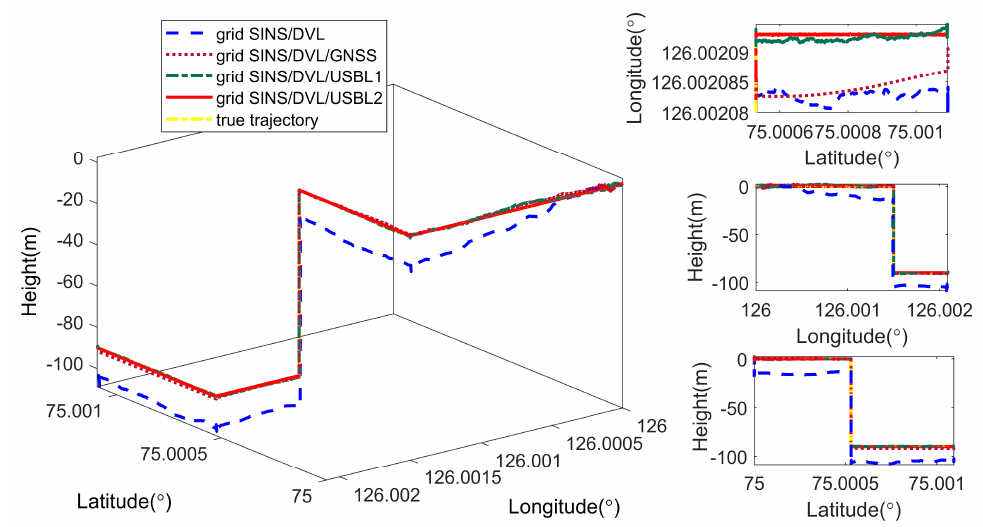
Figure 12. Position comparison between four integrated navigation strategies.